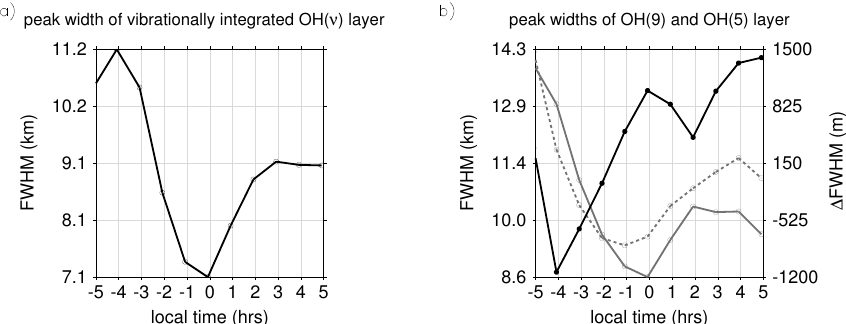
Fig. 8: Diurnal variability of OH peak widths for the same spatial and temporal bin considered in Fig. 7. Panel (a)/left axis: Full peak widths of OH(9) and OH(5) layers (dashed and solid grey lines). Panel (b)/right axis: Relative difference between the full peak widths of the OH(9) and OH(5) layers (black solid line).